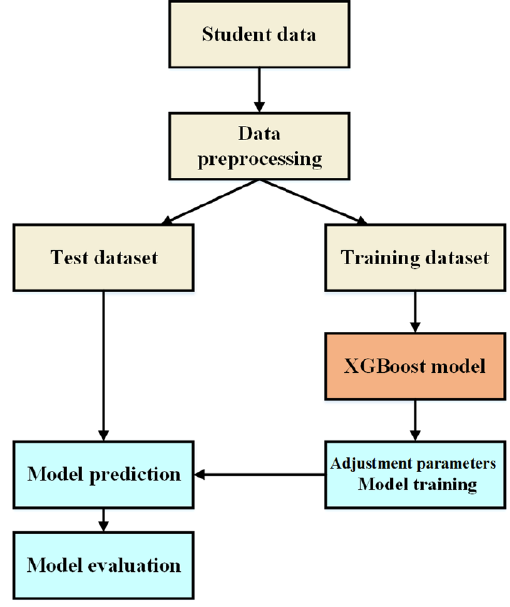
Fig. 1 Flow chart of XGBoost knowledge tracing